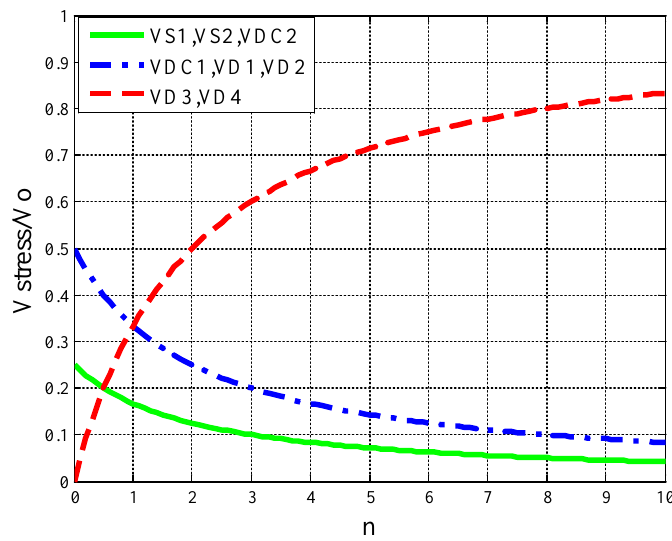
Figure 6. Normalized semiconductor-device voltage stresses versus turns ratio n .